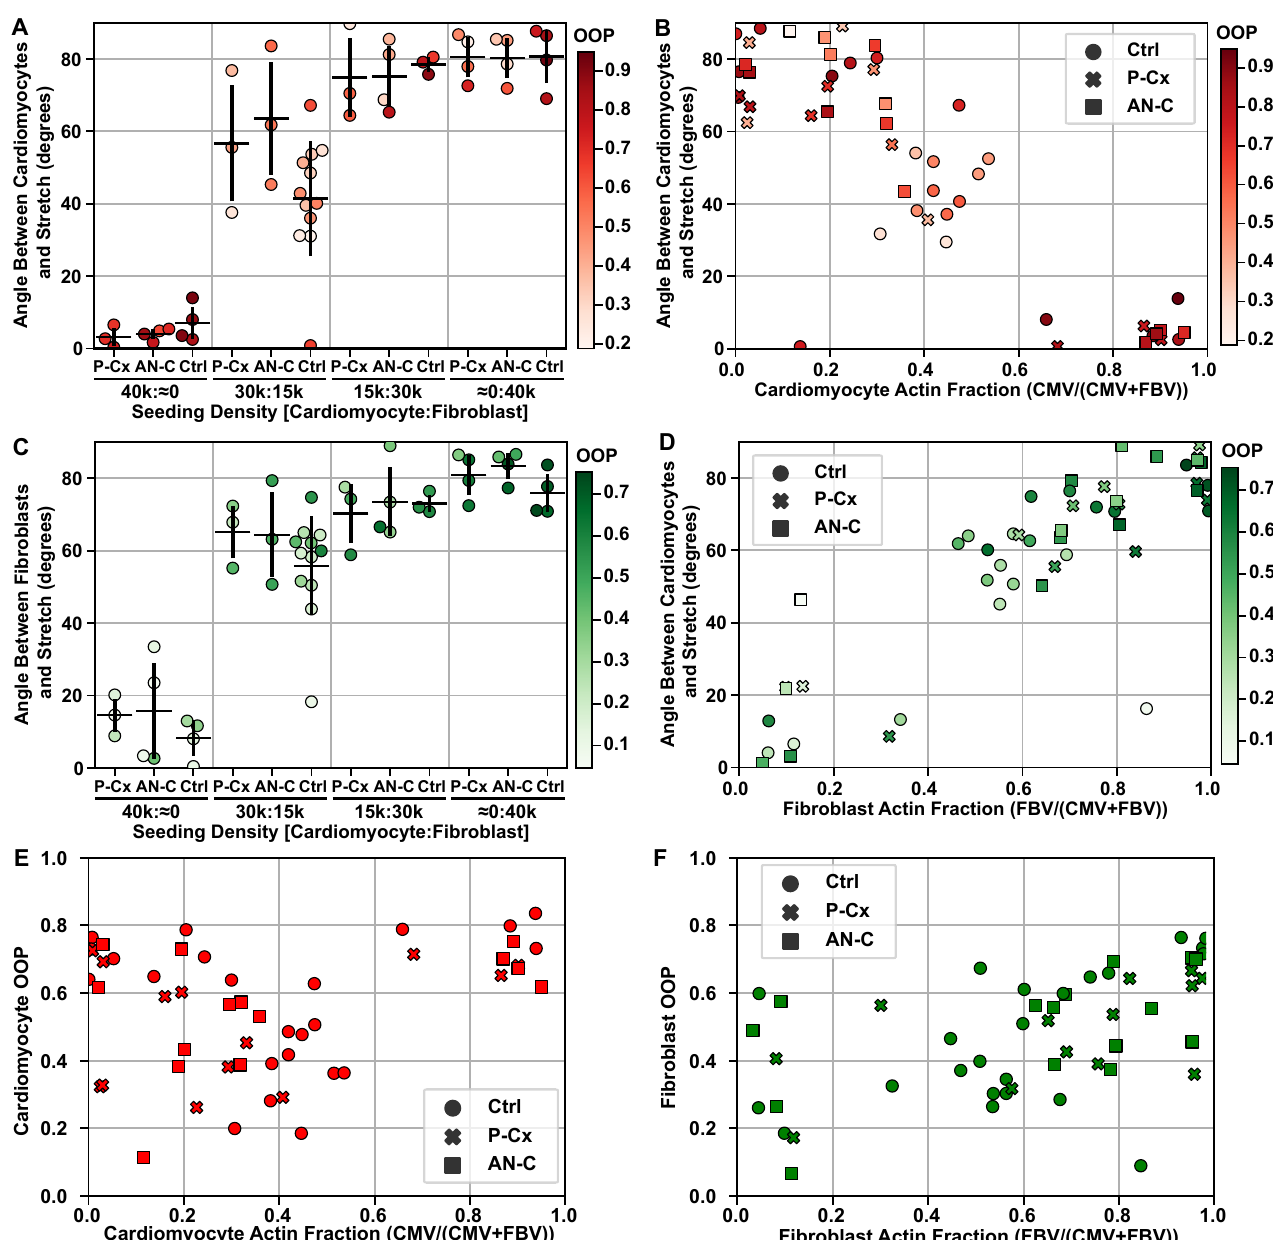
Figure 4. Co-cultures treated with drugs. Representative images of different experimental co-culture densities. ‘( A ) The average and standard deviation of the angle between the cardiomyocyte actin director and stretch director for each experimental seeding density. ( B ) The angle between the cardiomyocyte actin director and stretch director for the measured cell type actin fraction, i.e., the total number of cardiomyocyte actin vectors divided by the total number actin vectors. ( C ) The average and standard deviation of the angle between the fibroblast actin director and stretch director for each experimental seeding density. ( D ) The angle between the fibroblast actin director and stretch director for the measured cell type actin fraction, i.e., the total number of fibroblast actin vectors divided by the total number actin vectors. ( E ) Cardiomyocyte OOP as a function of actin fraction. ( F ) Fibroblast OOP as a function of actin fraction. In ( A – F ), each point represents a single well, which is colored by the actin OOP for cardiomyocytes ( A , B , E ) or fibroblasts ( C , D , F ). Sample sizes of each experimental condition can be found in Table A1. In ( A , C ), horizontal bars indicate groups with significantly different means ( p <